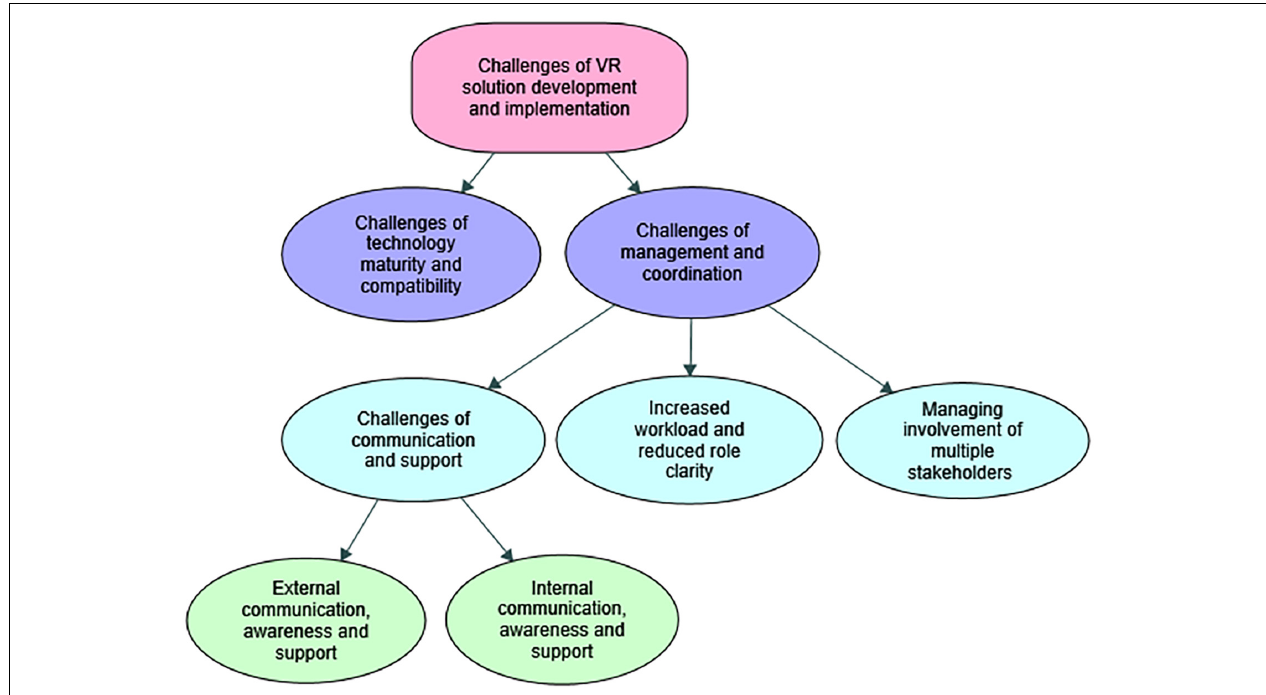
FIGURE 2 | A thematic map of the challenges of the developer organization for the development and implementation of the VR solution in the specific